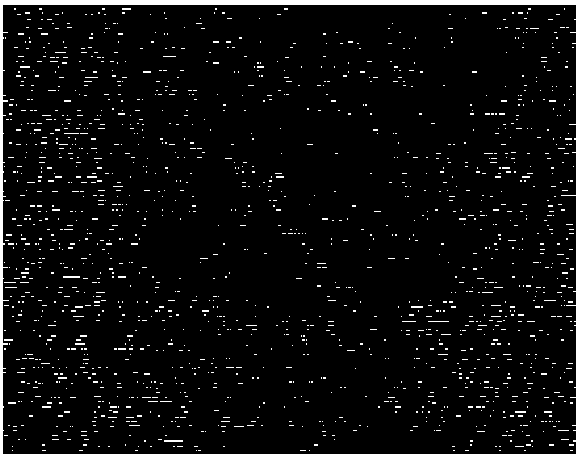
Figure 6. The output of pre-filtering of image in Fig. 1